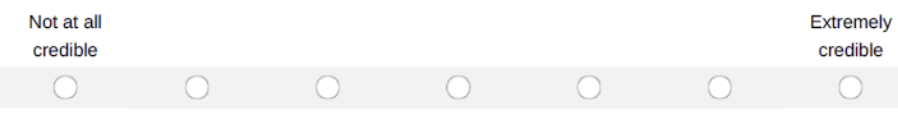
Figure A3. Manipulated image